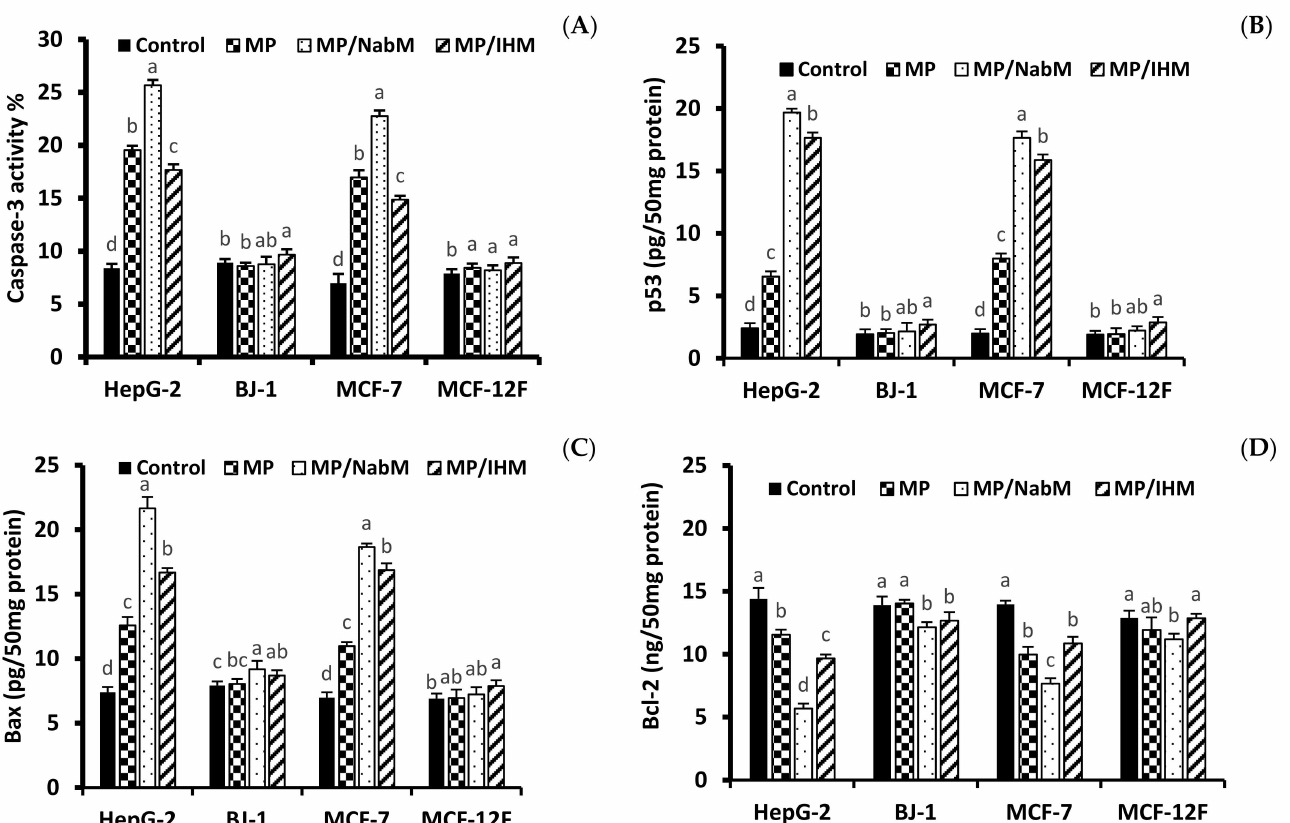
Figure 8. Protein levels of apoptosis biomarker. The level of Caspase-3 ( A ), p53 ( B ), Bax ( C ), and Bcl-2 ( D ) in HepG-2, MCF-7, Bj-1, and MCF-12F treated with or without the IC 50 of MP, MP/NabM, and MP/IHM. MP: milk proteins concentrate; MP/NabM: milk proteins/Nabeq mucilage complex; MP/IHM: milk proteins/Isabgol husk mucilage complex. Data are average of triplicates. Measurements with different letters (a, b, c and d) are significantly different ( p <